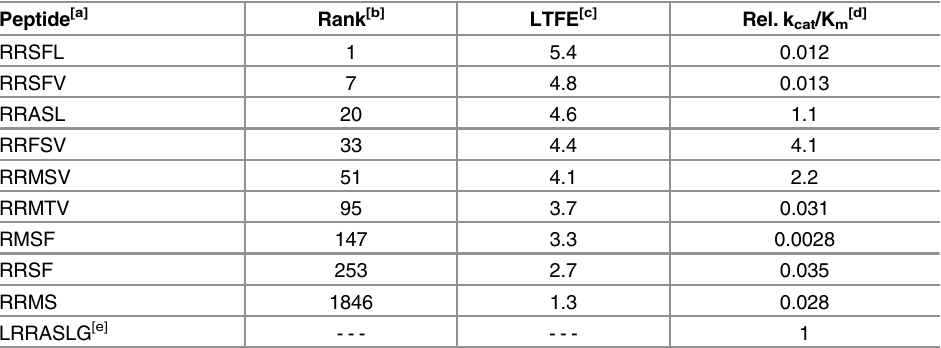
To identify the most highly enriched peptides, we summed the reads for the 6 4 (1296) differ- ent genes corresponding to each peptide sequence. The dominant sequence motifs in the fourth generation data set were RRX[S/T] (cid:3) and RRSFX, where the letter X is generally a hydrophobic Table 1. k cat /K M values for resynthesized peptides.